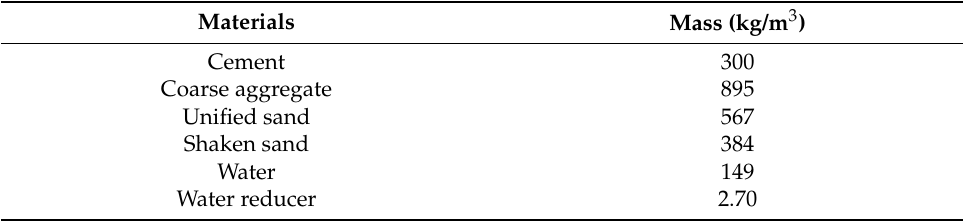
Table 2. Concrete mix proportion for the reference concrete without